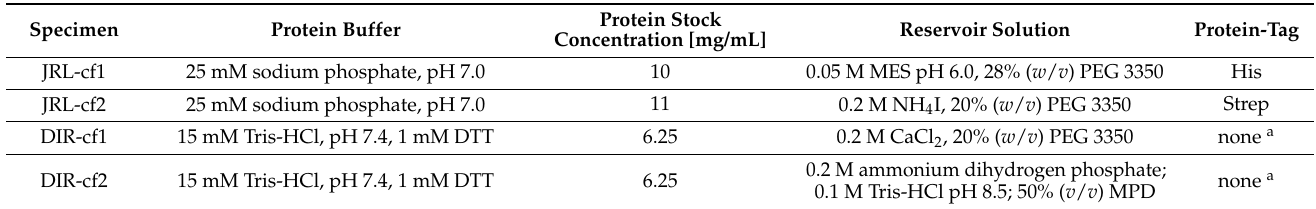
Table 1. Experimental conditions for crystallization of the two Os JAC1